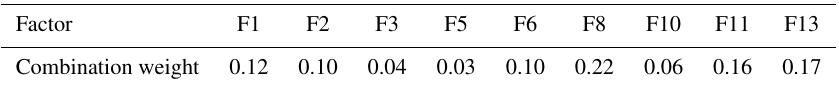
Table 14. The combined weighted values of the